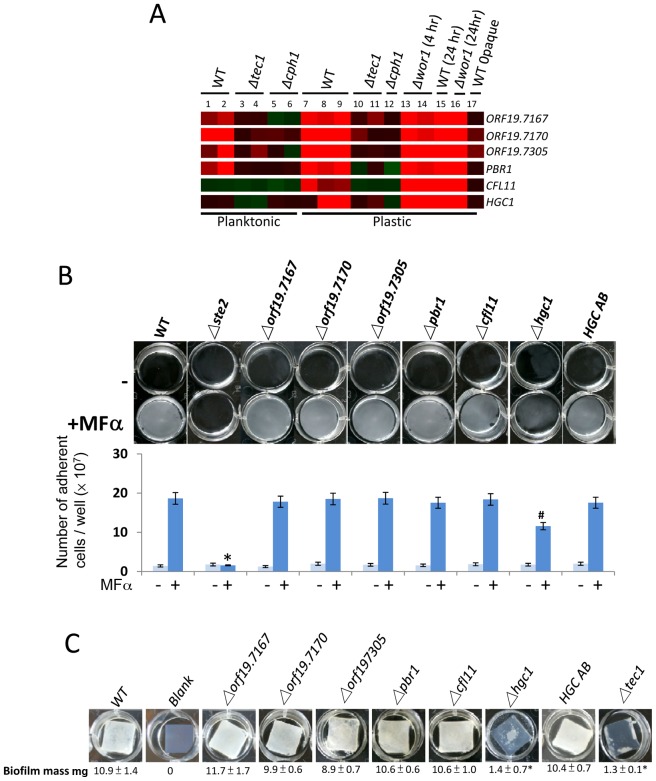
Examination of six downstream targets of Cph1 and Tec1 reveals a general role for Hgc1 in biofilm formation.(A) Heatmap showing expression of six target genes that are regulated by Cph1 and Tec1 during pheromone treatment of white cells. (B) Pheromone-stimulated biofilm formation in mutants lacking each of the six candidate genes. Top panel, images of white cells adhering to plastic. Bottom panel, quantification of the number of adherent cells. Light blue bars on graphs, no pheromone added. Dark blue bars, MFα pheromone present. (C) Analysis of the six candidate genes in a conventional biofilm assay on silicone squares. Hgc1 and Tec1 are both necessary for conventional biofilm formation. Values are the mean ± SD from two independent experiments with at least three replicates. “#” represents P<0.01 and “*” represents P<0.001 for the difference with the wildtype strain. The complemented HGC1 strain (HGC AB) showed a significant increase in biofilm formation compared to the hgc1 mutant. (WT: CAY716; Δste2/Δste2: CAY1234; Δorf19.7167/Δorf19.7167: CAY3445; Δorf19.7170/Δorf19.7170: CAY3447; Δorf19.7305/Δorf19.7305: CAY3693; Δpbr1/Δpbr1: CAY3689; Δcfl11/Δcfl11: CAY3687; Δhgc1/Δhgc1: CAY3465; HGC1 AB: CAY3702).